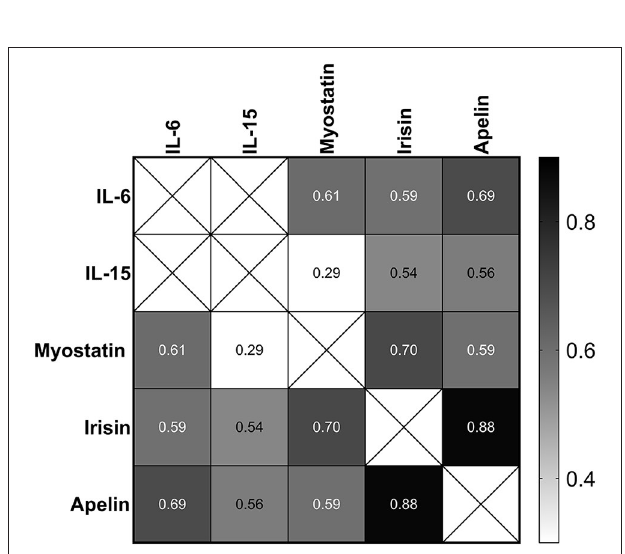
FIGURE 8 | Correlation between the changes in IL-6, IL-15, myostatin, irisin, and apelin 72h after the race. The values are presented as Spearman’s r of 39 runners for irisin, 40 runners for apelin, and 43 runners for IL-6, IL-15, and myostatin. Colormap with range between 0.3 and 0.9 and black for the largest value and white for the smallest value.